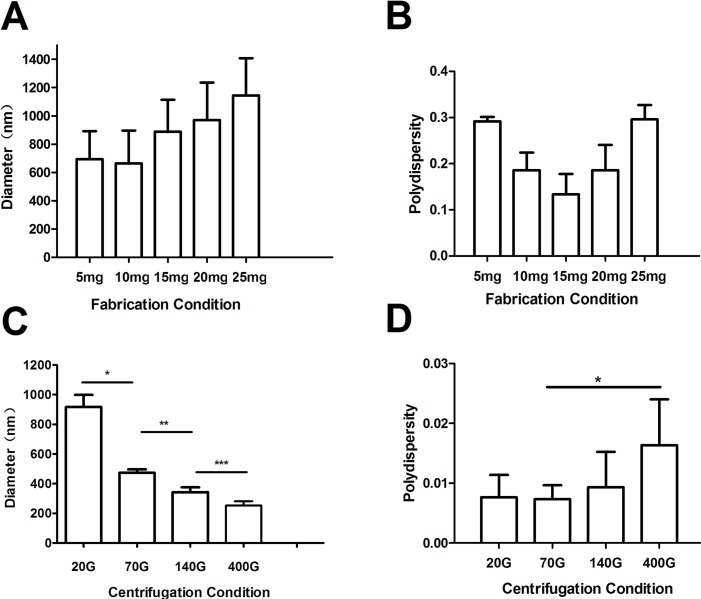
The mean diameter and polydispersity of nanobubbles prepared by controlling phospholipid film thickness and different centrifugations. (A) Histogram of the average diameter of the bubbles produced with 5 mg, 10 mg, 15 mg, 20 mg, and 25 mg phospholipid. (B) Polydispersity of nanobubble produced with 5 mg, 10 mg, 15 mg, 20 mg, and 25 mg phospholipid. (C) Histogram of the average diameter of the bubbles prepared using centrifugation speeds of 20 g, 70 g, 140 g, and 400 g. (D) Polydispersity of nanobubbles prepared using centrifugation speeds of 20 g, 70 g, 140 g, and 400 g.